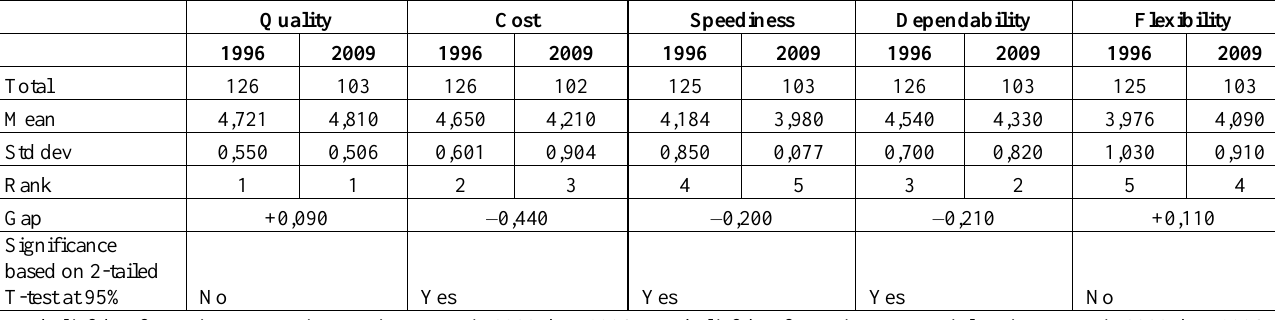
Table 13: Future importance internationally: 1996 versus